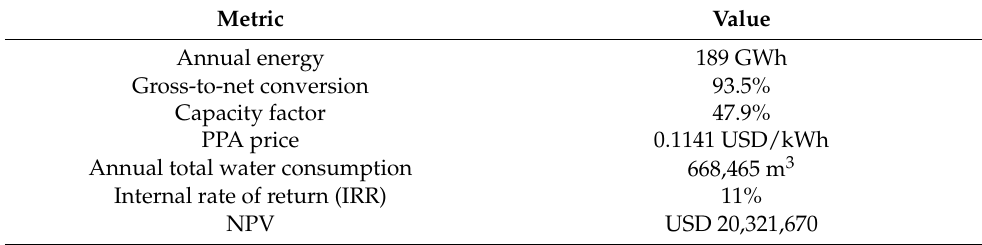
Table 4. Results of simulations for the investigated PTC plant for both cooling modes . Table 5. Simulation results for the optimized 50 MWe PTC plant.